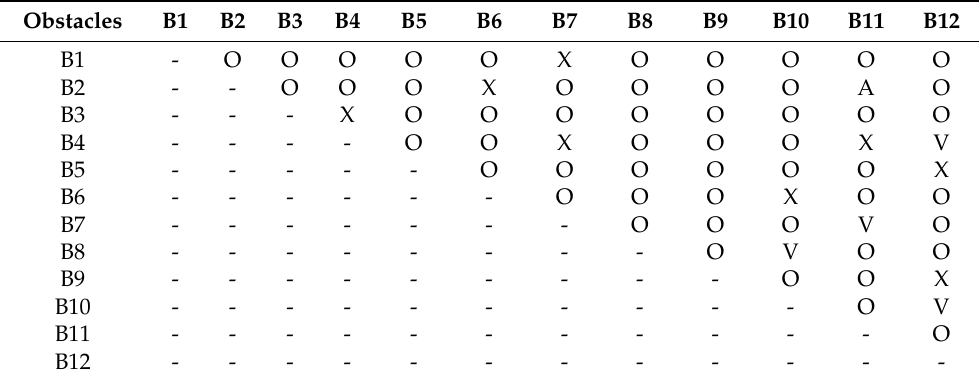
Table 6. Structural self-interaction matrix